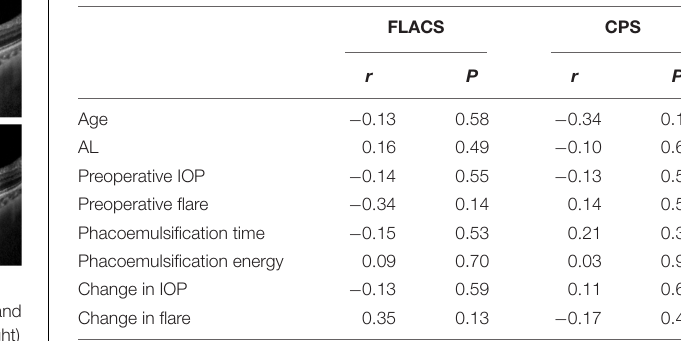
TABLE 2 | Correlations of various factors with the peak change in the subfoveal choroidal thickness in the FLACS and the CPS